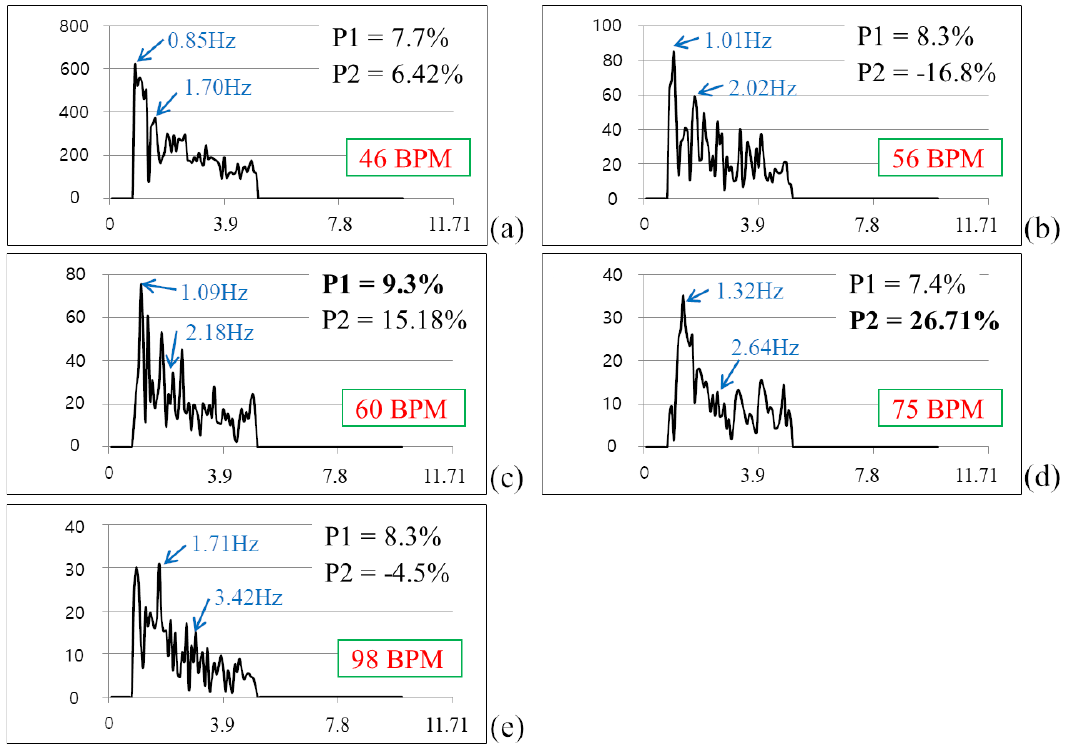
Figure 9. Example showing that the signal selection results of P1 and P2 differ. ( a – e ) Magnitude spectrum of the first five principal component signals. The frequency with the greatest magnitude and its first harmonic is shown with blue arrows and frequency values. These signals were brought from a case where the ground-truth heart rate was 74 beats per minute (BPM) ( ≈ 1.23 Hz). With both methods, a greater percentage indicates greater signal periodicity. The periodicity indices computed by P1 have lower variance (1–2%) than those computed by P2, which indicates that those computed by P2 are more discriminative and more robust to